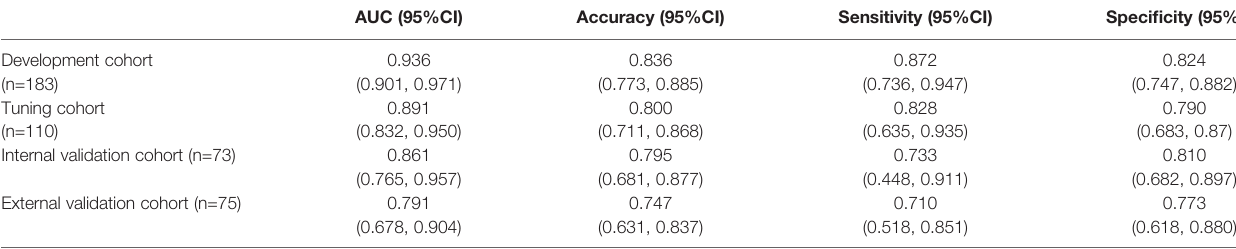
AUC, area under the receiver operating characteristics curve; CI, con fi dence